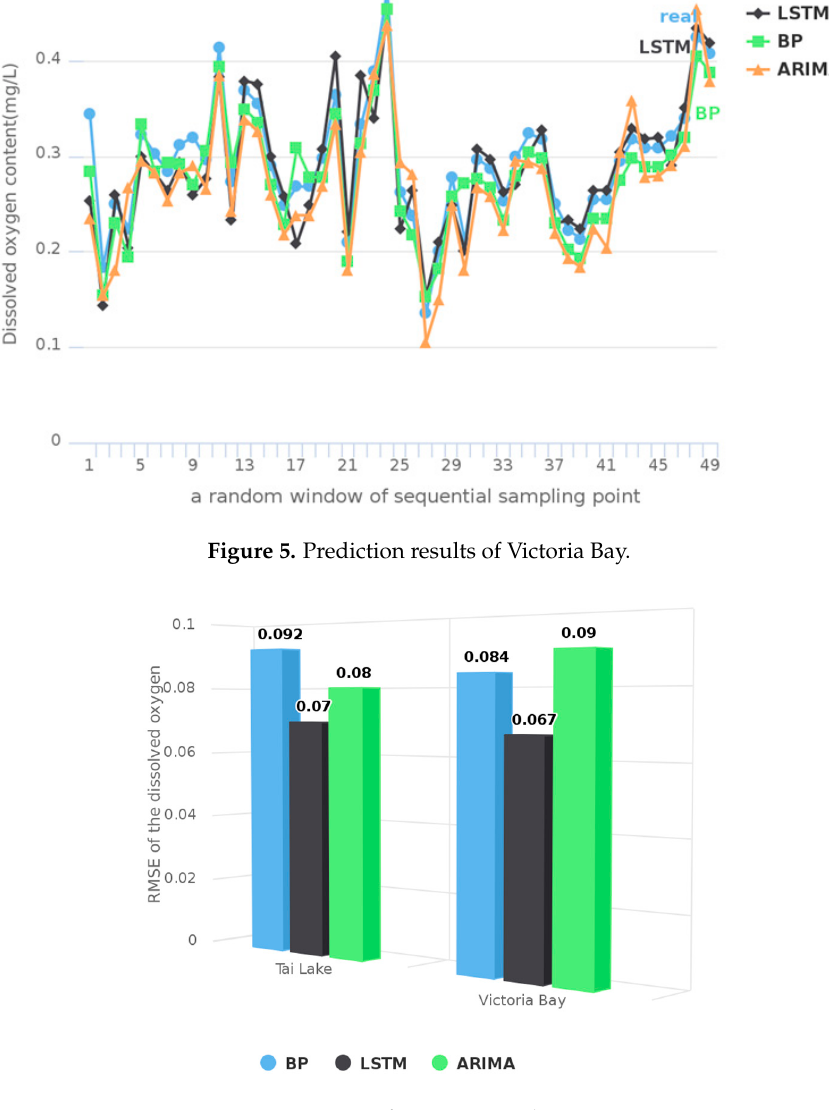
Figure 6. RMSE of BP, LSTM and ARIMA.